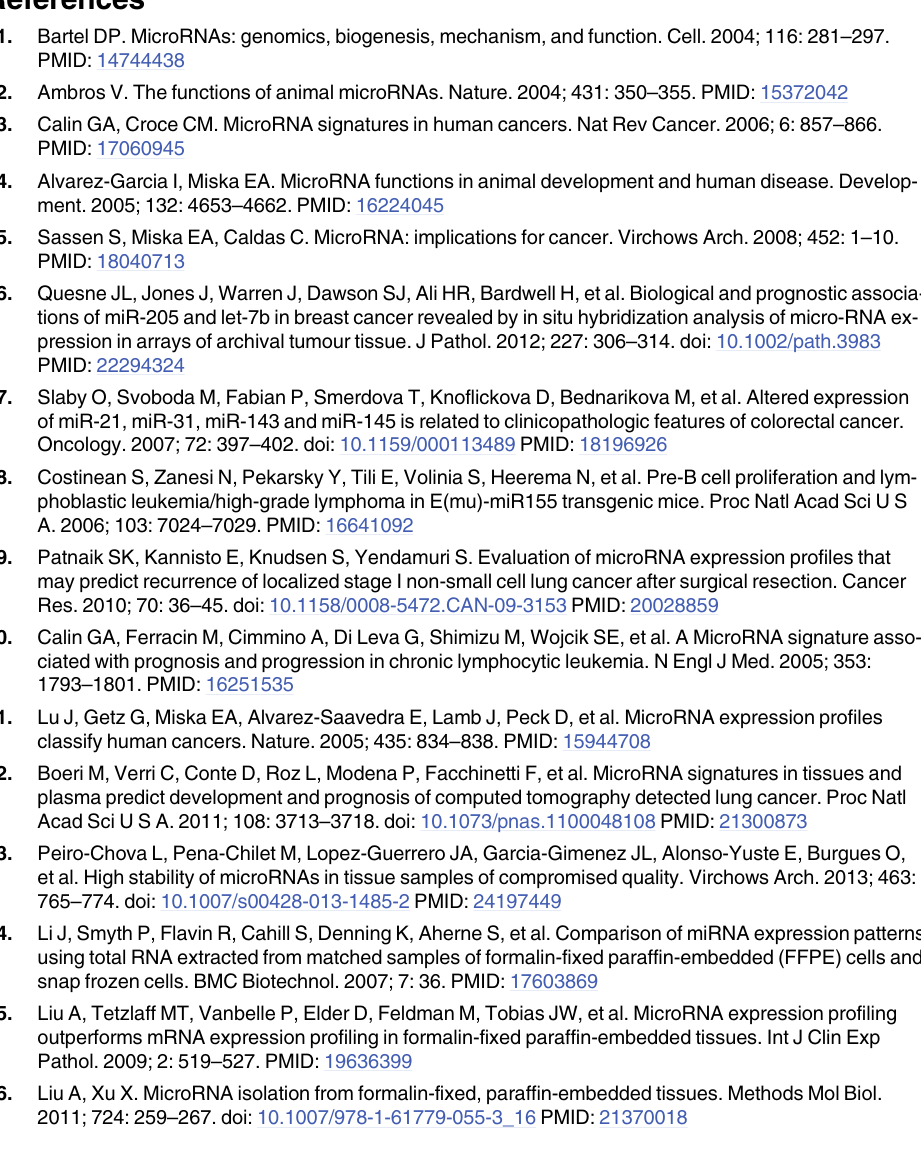
S2 Table. Six studies that have assessed RNA sequencing for profiling microRNAs in for- malin-fixed, paraffin-embedded